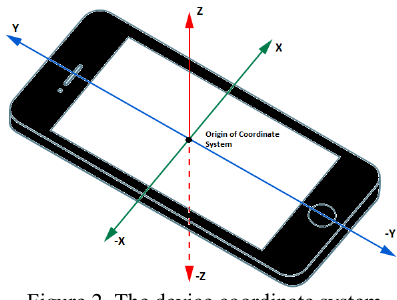
Figure 2. The device coordinate system